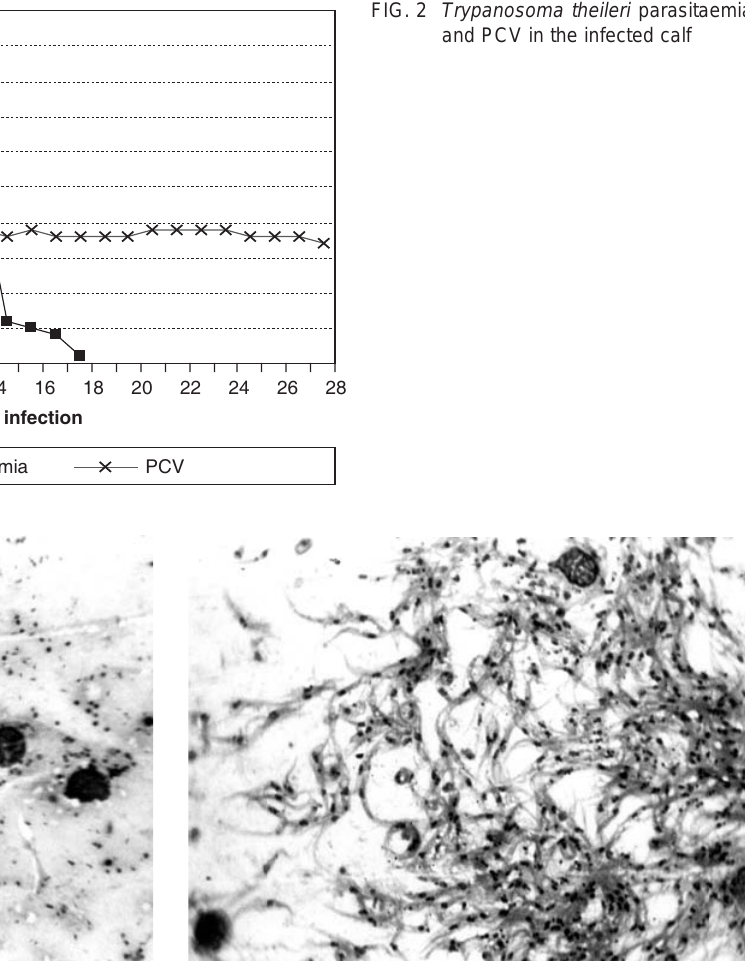
FIG. 4 Haemolymph smear showing a high infestation with dif- ferent developmental stages of T. theileri